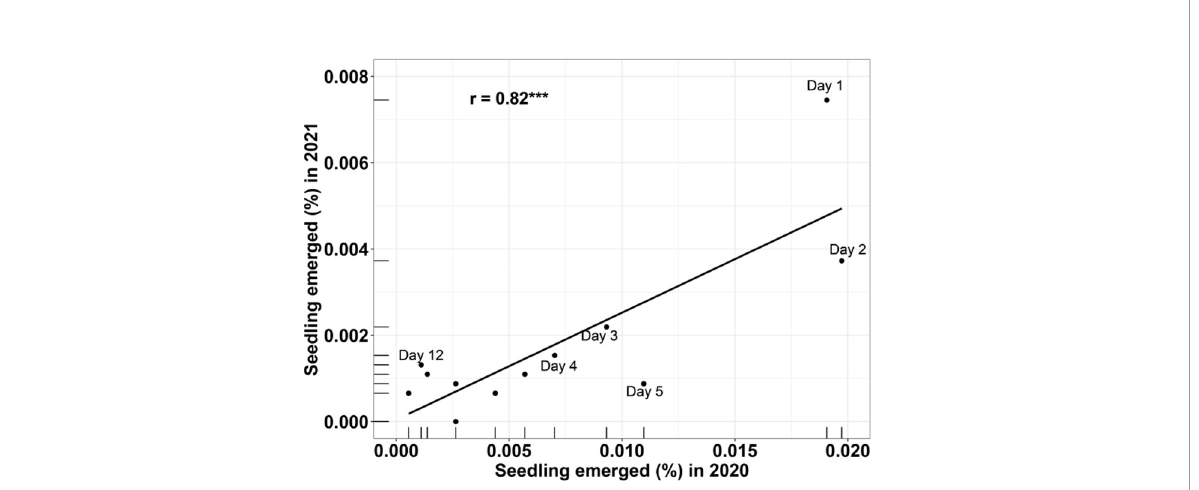
FIGURE 2 Correlation between seedling emergence (%) in sheep-feeding trial (experiment 2) in 2020 and 2021 at different days after feces collection. *** = highly signi fi